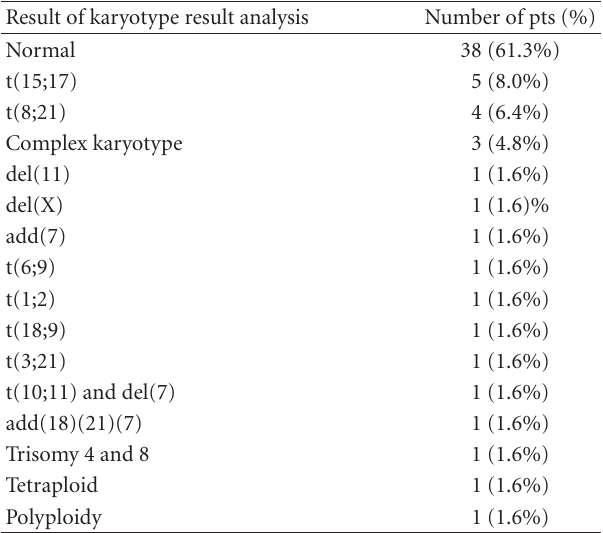
Table 1: Karyotypic characterization of our